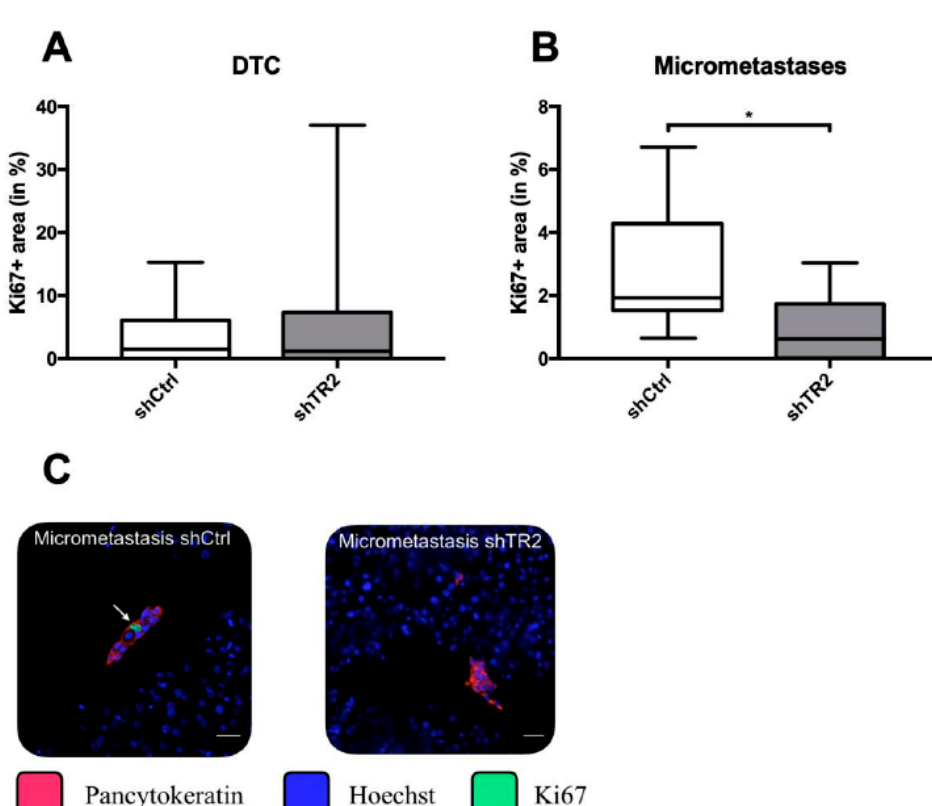
Figure 2. Micrometastases of animals inoculated with PancTu-I shTR2 cells show lower proportion of Ki67 + tumor cells than micrometastases of animals inoculated with PancTu-I shCtrl cells. Proportions of Ki67 + PancTu-I shCtrl and PancTu-I shTR2 cells within ( A ) DTCs and ( B ) micrometastases were analyzed by immunofluorescence staining of Ki67. ( C ) Representative images of Ki67 staining of PancTu-I shCtrl and PancTu-I shTR2 liver micrometastases. Scale bars: 25 µ m. Data represent the mean ± SEM or median values with quartiles (Q 0.75 as upper, Q 0.25 as lower deviation) of 9 animals/group; * = p < 0.05.